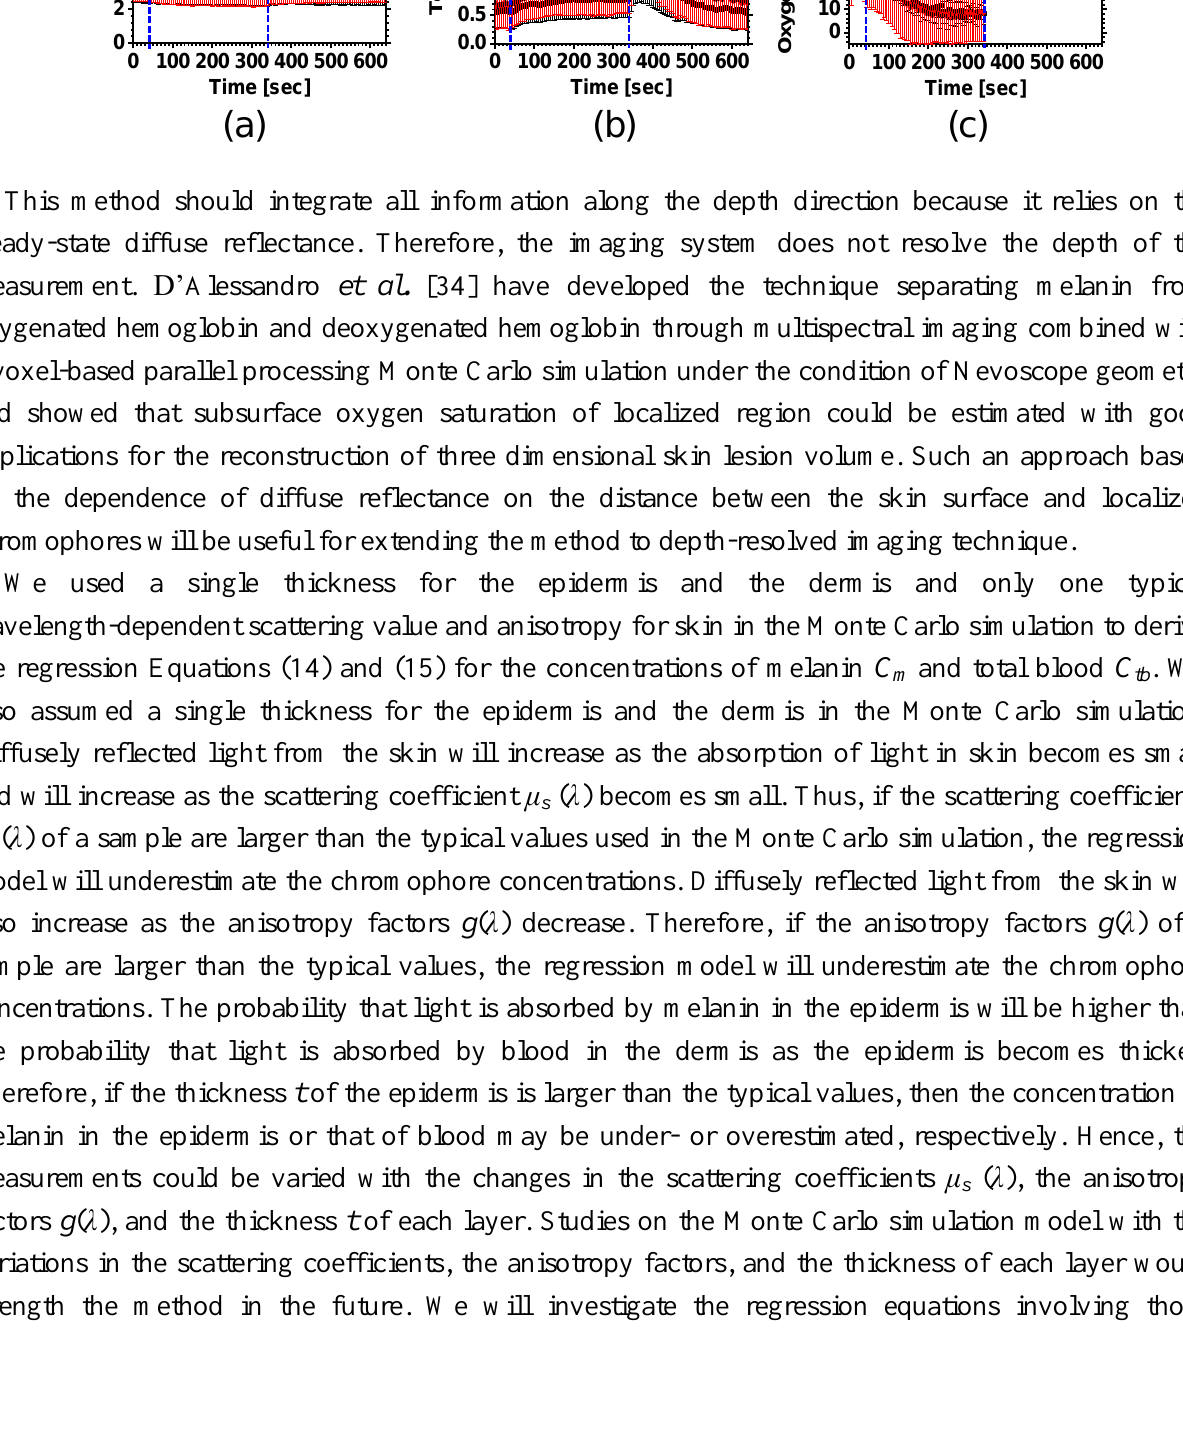
, ( b ) C , and ( c ) StO averaged over the ROIs (white m tb 2